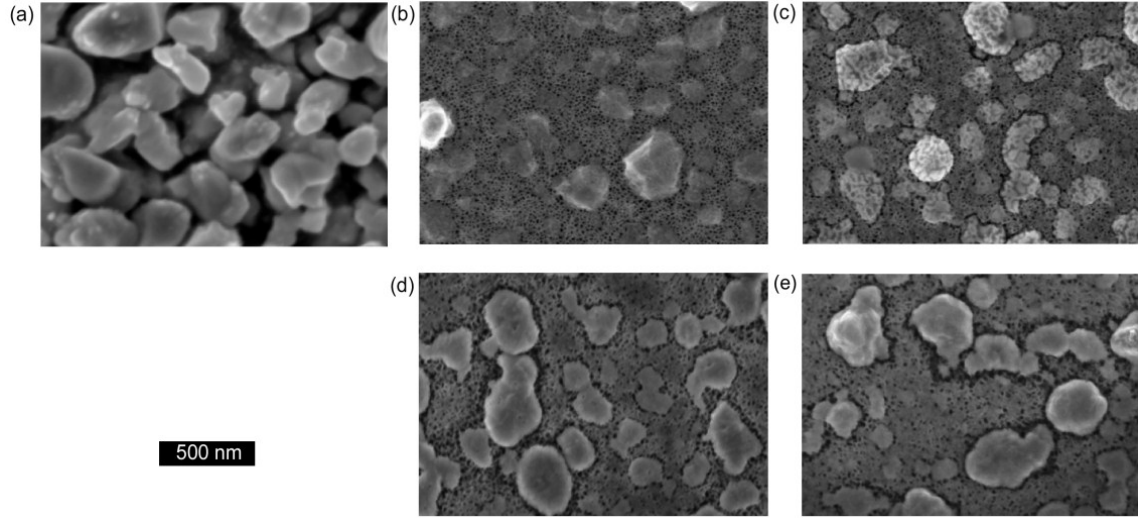
Figure 5. Scanning electron microscope images of nanoporous showing the change in morphology of sponge as a function of annealing temperature, ( a ) as-deposited at ≈300 °C; ( b ) immediately after de-alloying; ( c ) after heating to 50 °C; ( d ) after heating to 100 °C; ( e ) after heating to 330 °C (0.1 M NaOH, de-alloyed for 1